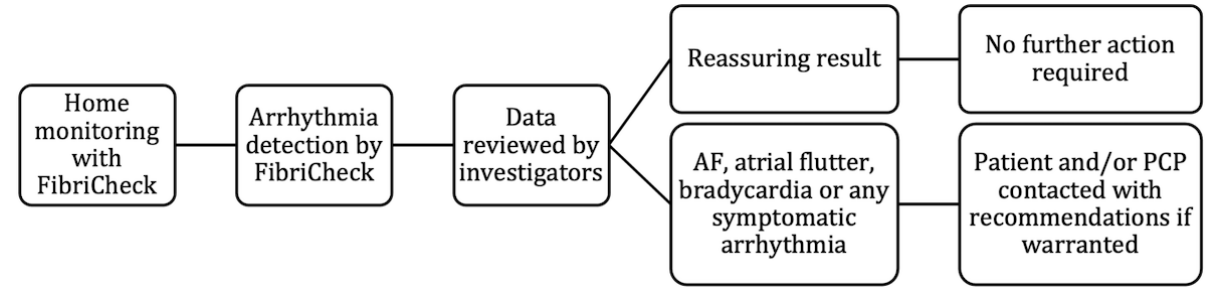
Figure 1. Schematic overview of the protocol for management of detected arrhythmias during the follow-up phase. AF: atrial fibrillation; PCP: primary care